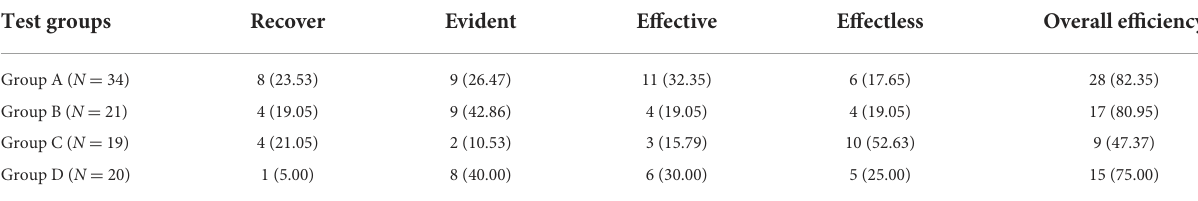
TABLE 2 Effective number of people in each group (overall efficiency) n